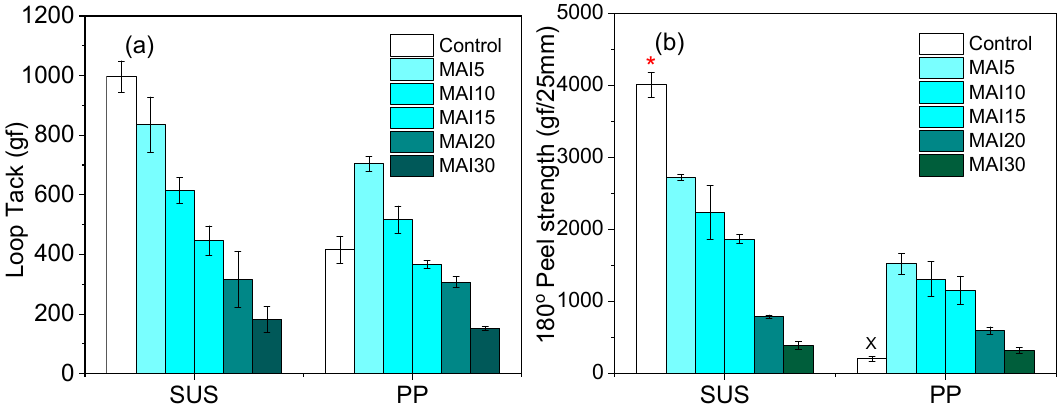
Figure 10. Loop tack ( a ) and 180° peel strength ( b ) of SPSA on stainless steel (SUS) and polypropylene (PP) substrates. The red asterisk denotes cohesive failure, and x denotes stick-slip behavior.